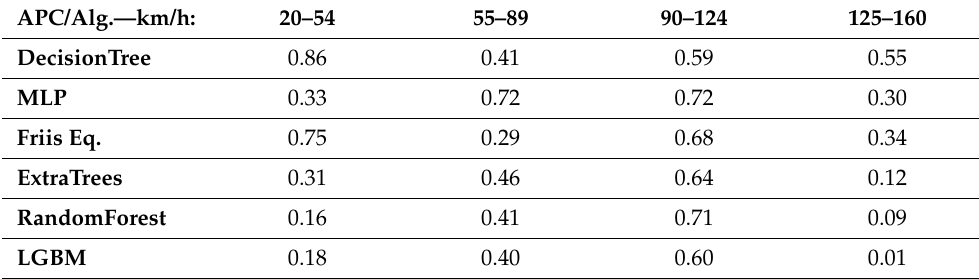
Table 5. The 4-classes—Classifiers ranking. Total APC per class and Friis equation total APC .